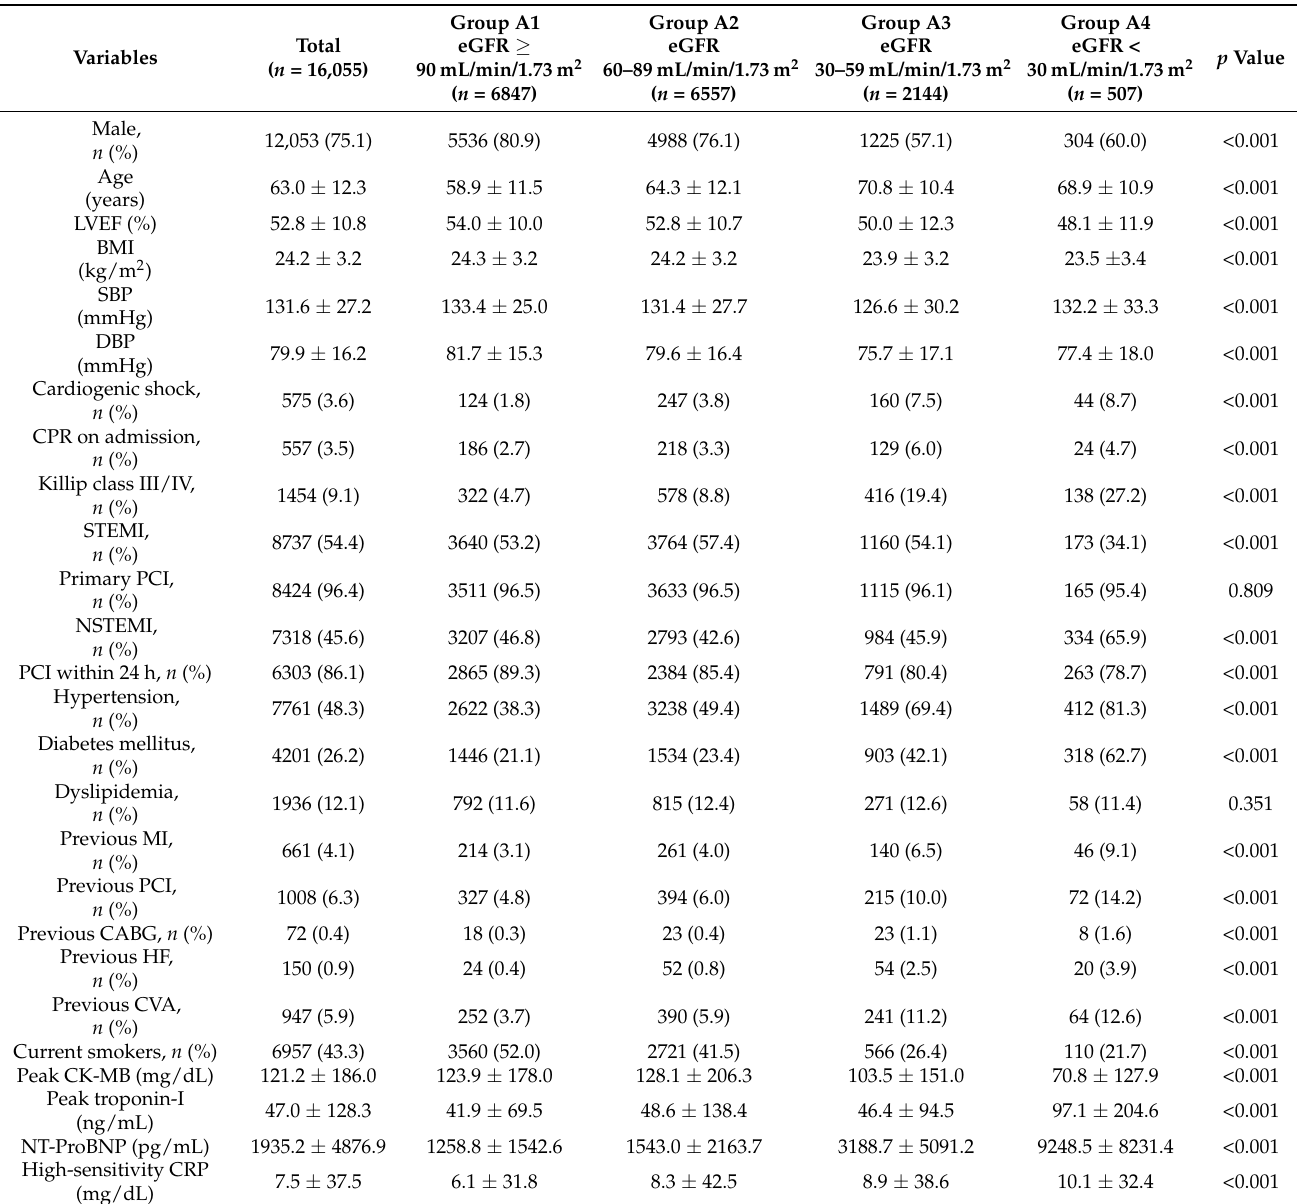
Table 1. Baseline characteristics of statin